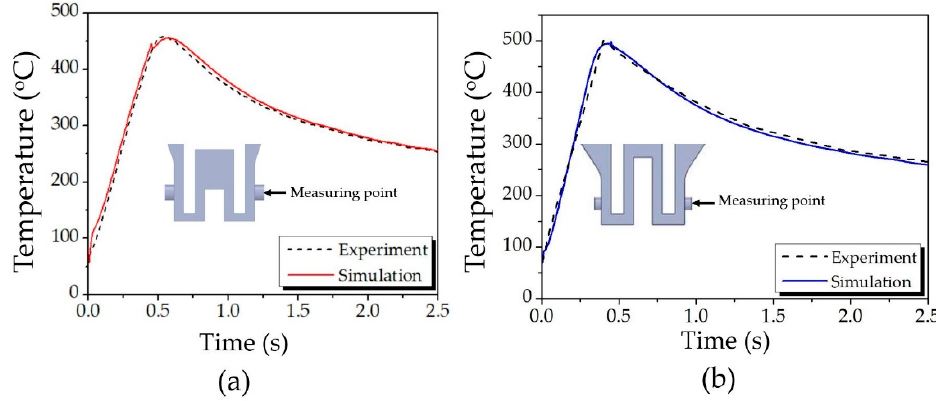
Figure 12. Temperature comparisons between the simulation and experimental results at measuring point in transient state for ( a ) series and ( b ) parallel WTs.